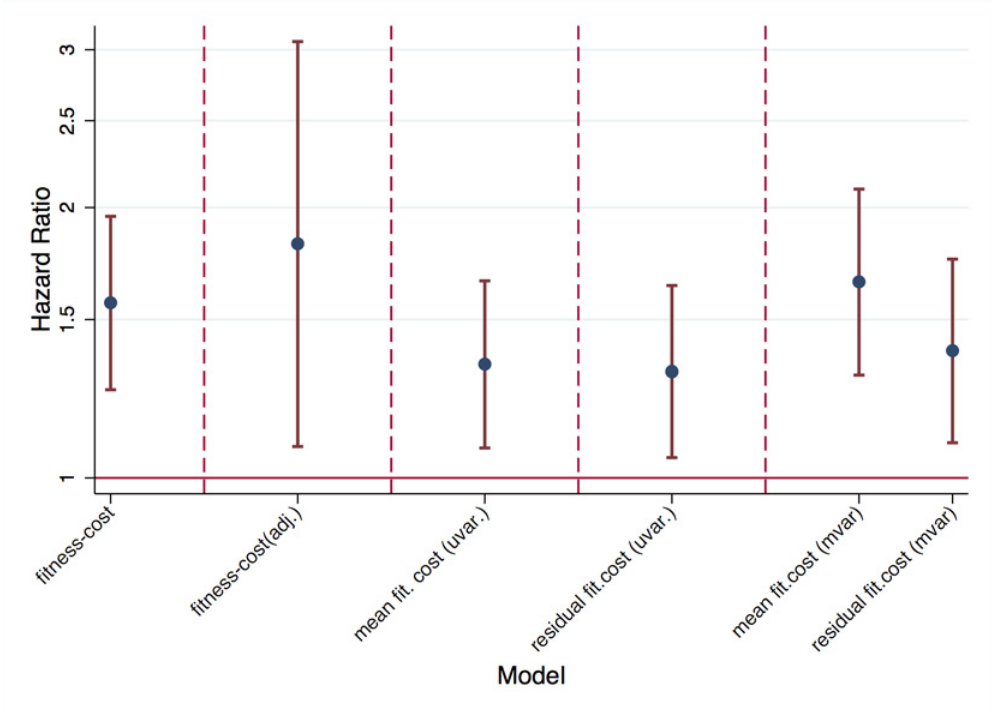
Fig 2. Impact of fitness cost on reversion rates. In unadjusted survival analysis ( “ fitness cost ” ), in survival analysis adjusted for type of mutation ( “ fitness cost adj. ” ). Impact of mean fitness cost and residual fitness cost in univariable analysis ( “ uvar. ” ) and in multivariable analysis including both mean and residual fitness cost ( “ mvar. ” ).